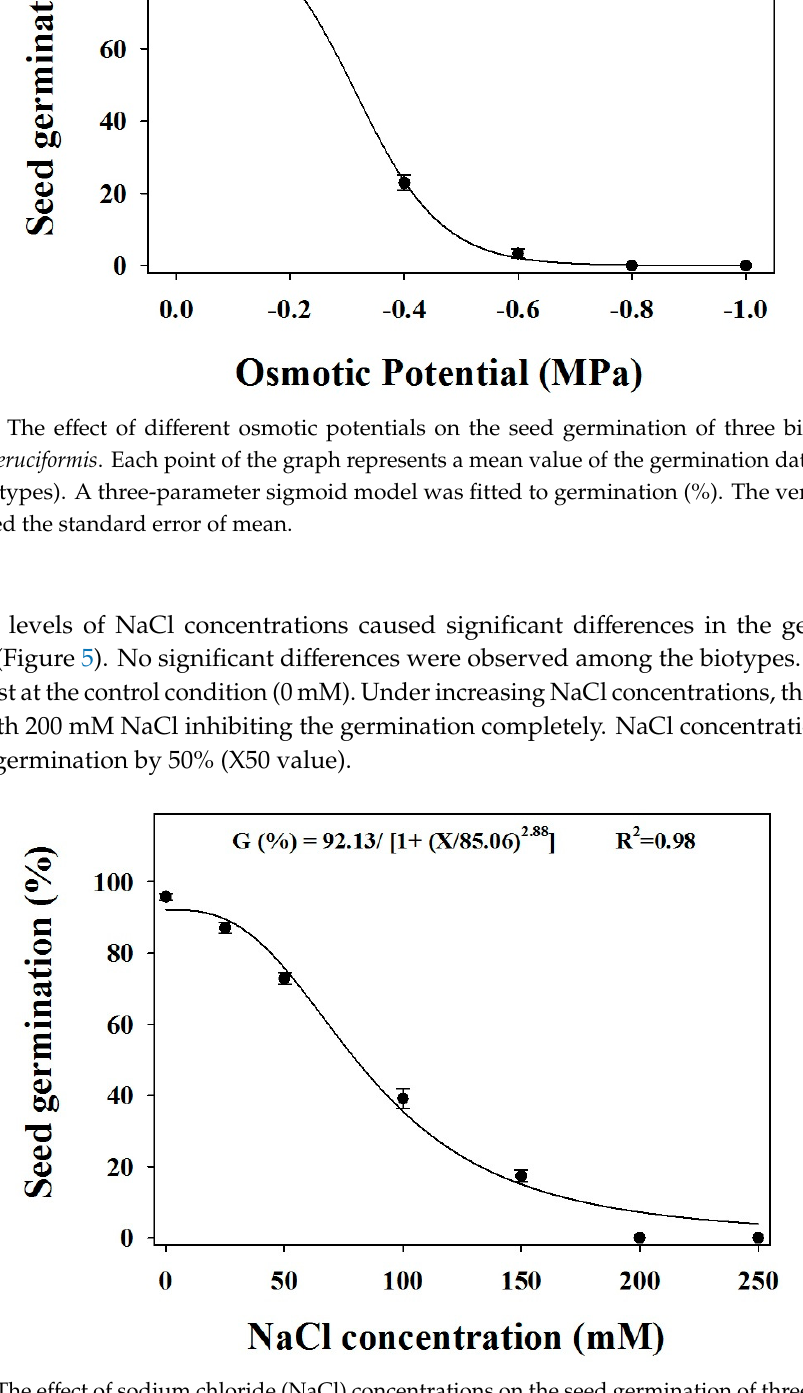
Figure 5. The effect of sodium chloride (NaCl) concentrations on the seed germination of three biotypes of B. eruciformis . Each point of the graph represents a mean value of the germination data (pooled across biotypes), as no significant differences were observed among biotypes. A three-parameter logistic model was fitted to the germination (%). The vertical bars represented the standard error of mean.